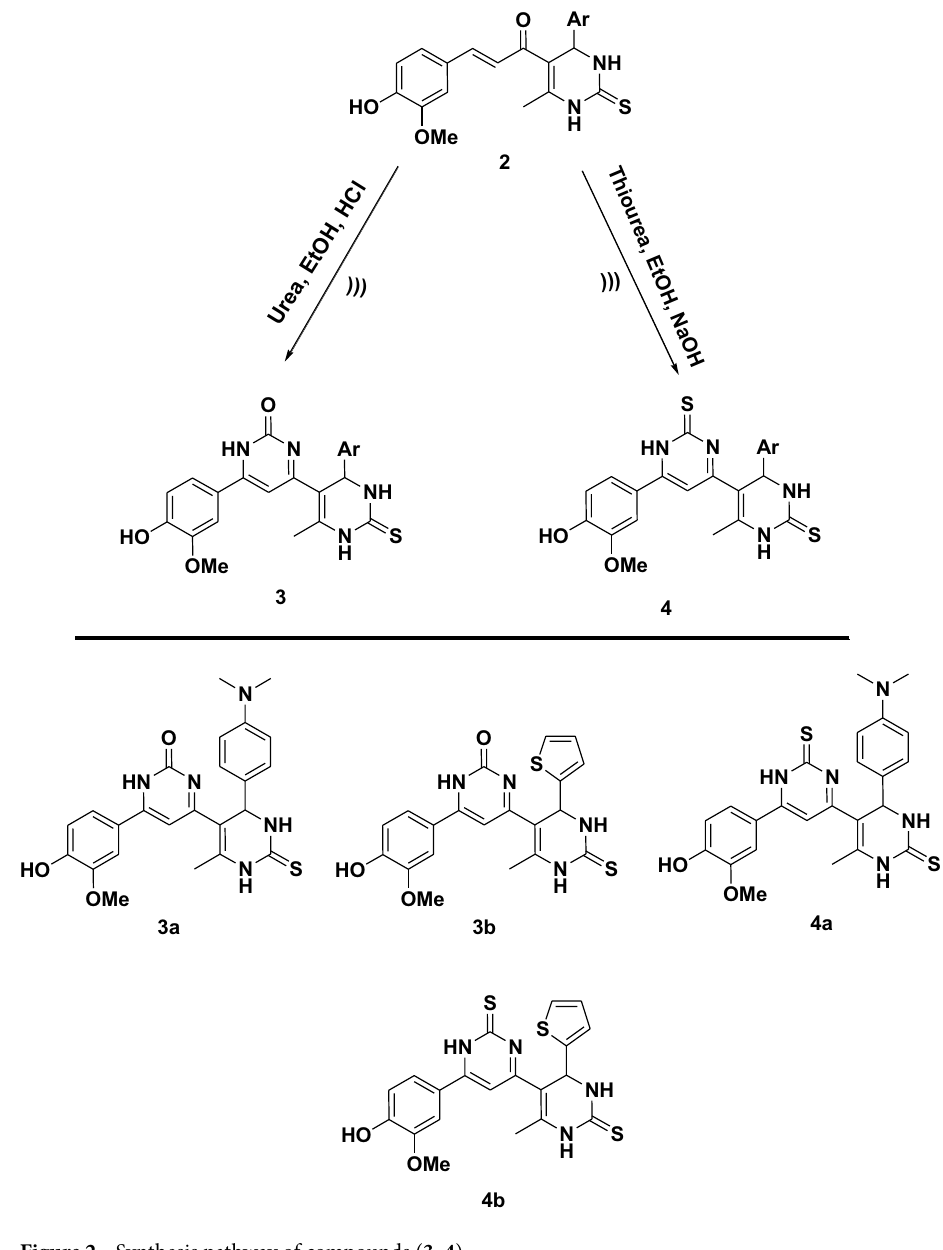
Figure 2. Synthesis pathway of compounds ( 3 , 4